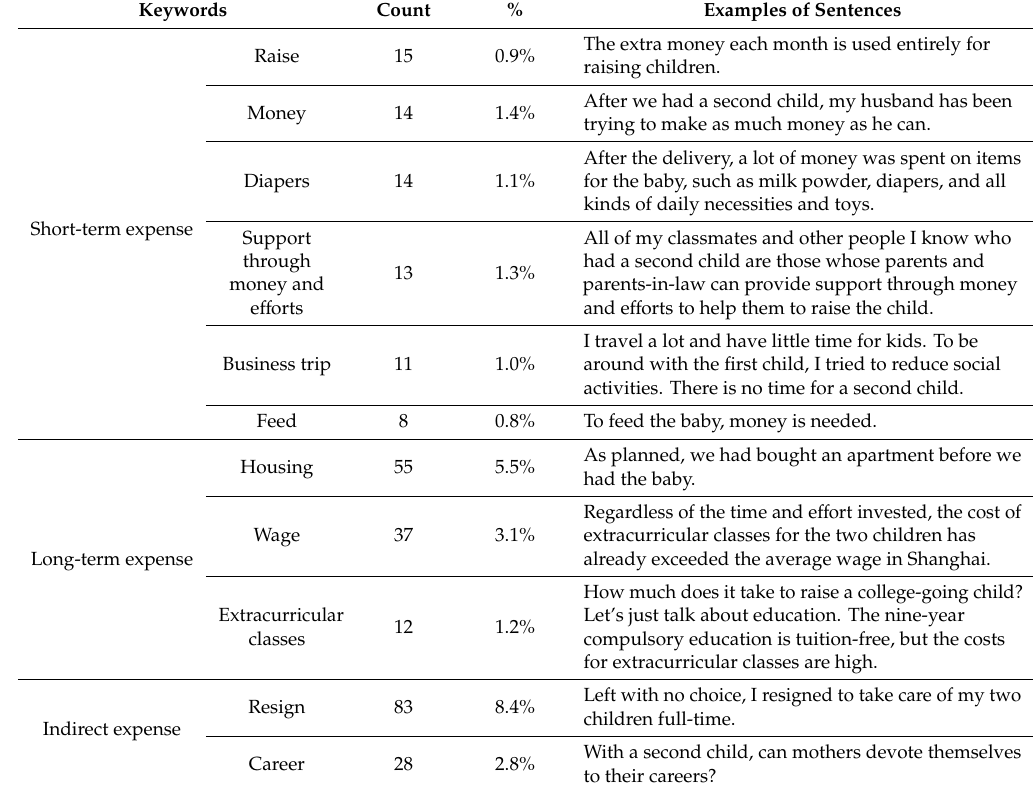
Table 3. Keywords indicating economic expenditure and sentence